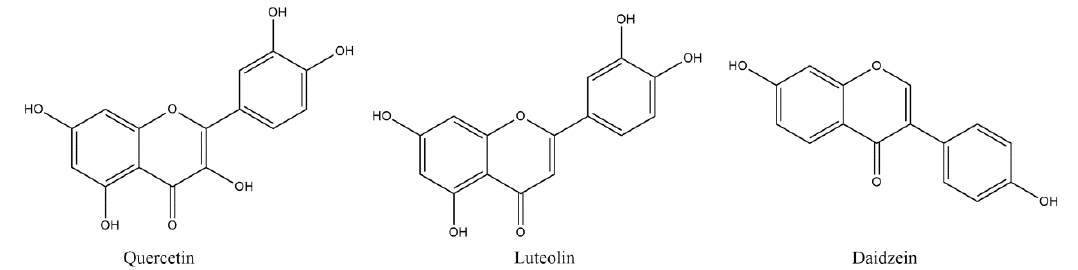
Figure 1. Structures of referred